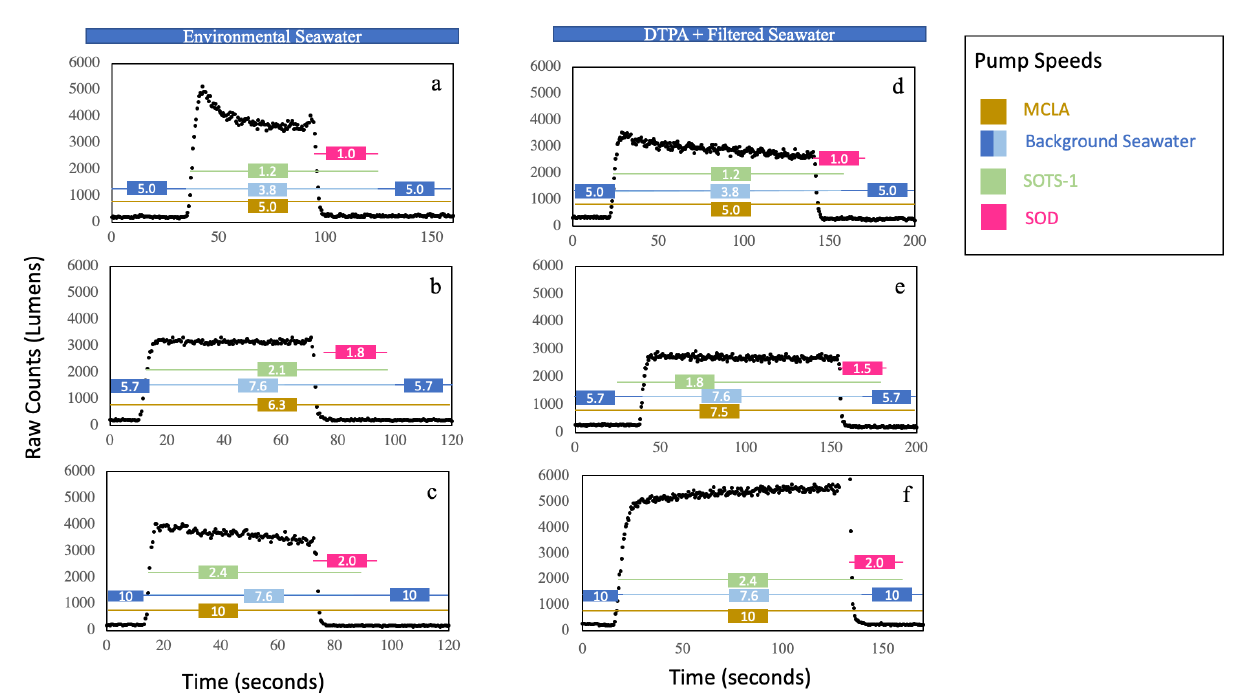
Figure 8. A series of calibrations done to test how the photon count detected by the PMT varied in response to different standard concentrations, flow speeds (given in the rectangular box for each respective reagent), and mediums for standard dilution (environmental seawater or DTPA amended and filtered seawater). Calibration solutions were diluted in-line with environmental seawater in ( a – c ), and with DTPA amended and filtered seawater in ( d – f ). The concentration of SOTS was decreased in tests ( b , e ) in comparison with ( a , c ). The effect of background medium flow speed was tested in ( e , f ). In ( a ) the initial decrease in signal is an effect of the lines not being filled with fluid when the test began, this can be avoided by priming the line in